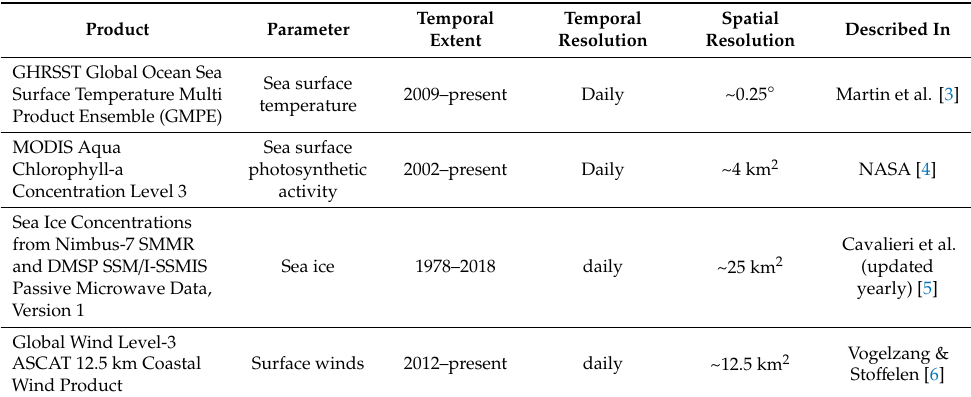
Table 1. A sample of existing hypertemporal datasets for ocean